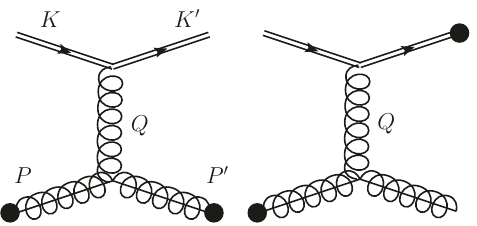
Figure 2 . Diagrammatic representation of the di(cid:11)usion and gain terms in soft gluon exchange processes. Double lines are hard quarks or gluons and the intermediate gluon is soft. The blobs represent the insertion of the deviation from equilibrium f 1 ( p ). The diagram on the left is a di(cid:11)usion term, entering in ( f g ( p ) f g ( p 0 )) 2 , whereas the one on the right is a gain term recording 1 1 (cid:0) the correlations between momentum p and k